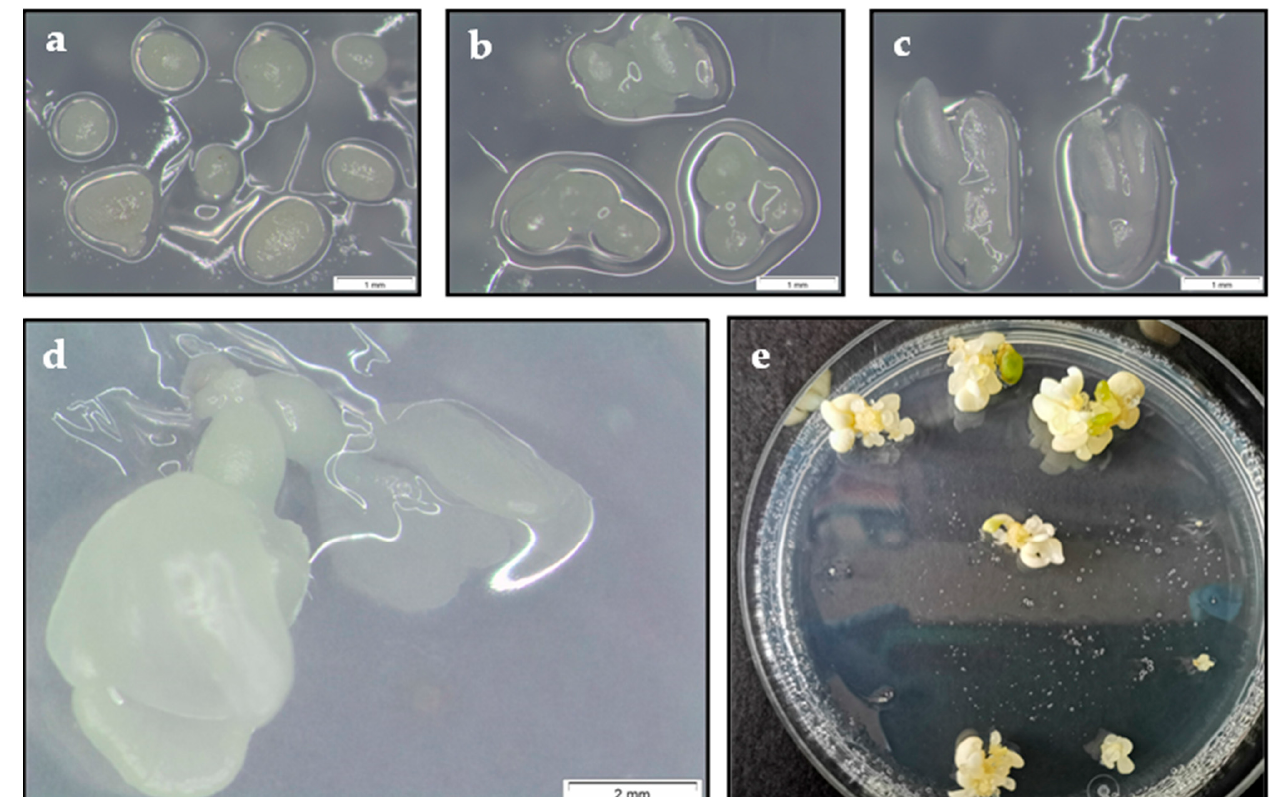
Figure 1. Cryopreservation of embryogenic cultures of holm oak by the vitrification-based method. a – c Show individual nodular embryogenic structures ( a ), groups of globular-heart stage embryos ( b ) and early cotyledonary stage embryos ( c ) isolated from line Q8. ( d ) Somatic embryos developed from a cryopreserved nodular embryogenic structure after 3 weeks of culture on proliferation medium. ( e ) Somatic embryo recovery from nodular embryogenic structures of line Q8 cryopreserved in liquid nitrogen for 4 years and cultured on proliferation medium for 8 weeks. Diameter of Petri dish, 90